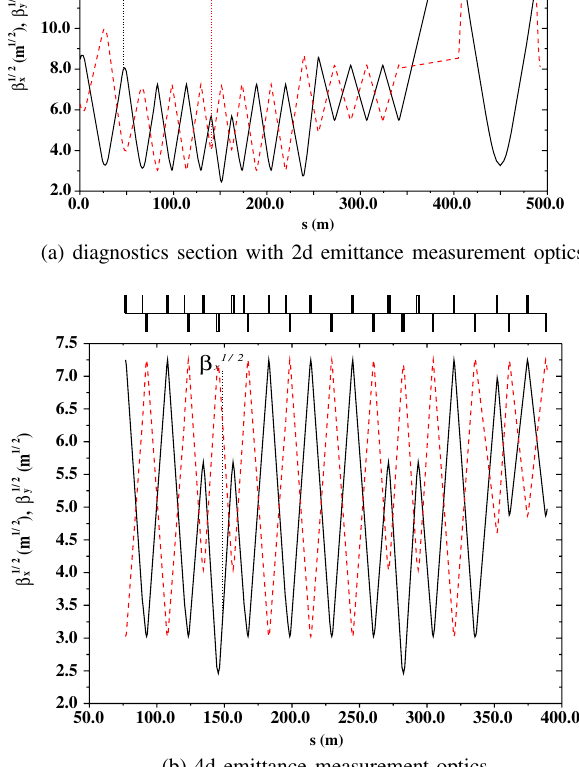
FIG. 9. (Color) (cid:6) -functions for the ILC diagnostics section comprising a 2D emittance measurement section; (cid:6) -functions for the 4D emittance measurement